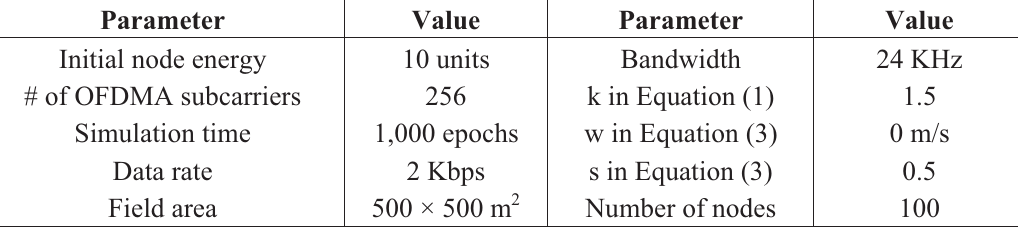
Table 4. Input parameters used in the